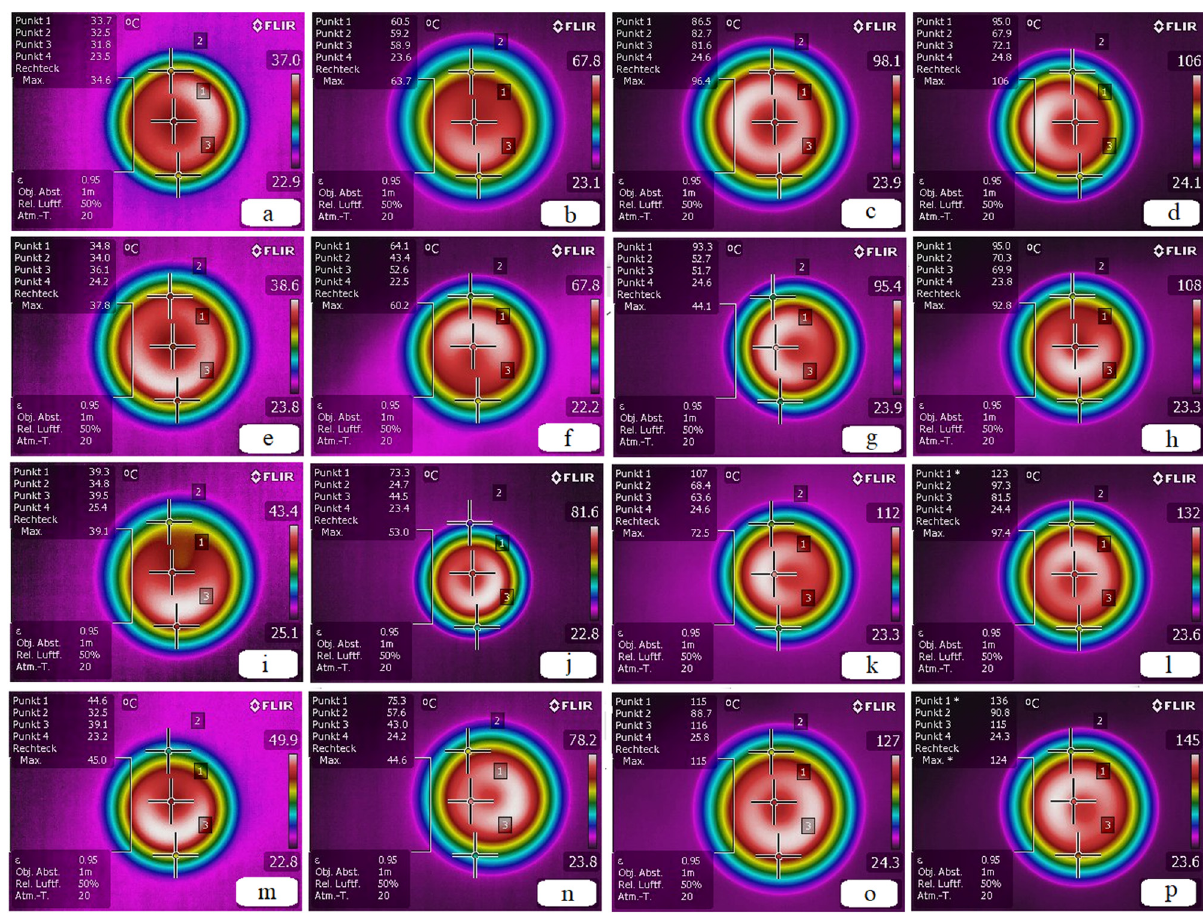
Figure 6: Infrared thermal image: WMA additive ( a – d ) with CSNPs, ( e – h ) without CSNPs; without WMA additive ( i – l ) with CSNPs and ( m – p ) without CSNP; in di ff erent thermal zones: ( d, h, l, p ) 120 s, ( c, g, k, and o ) 90 s, ( b, f, j, and n ) 60 s, and ( a, e, I, and m ) 30 s. The sample ’ s diameter is 18